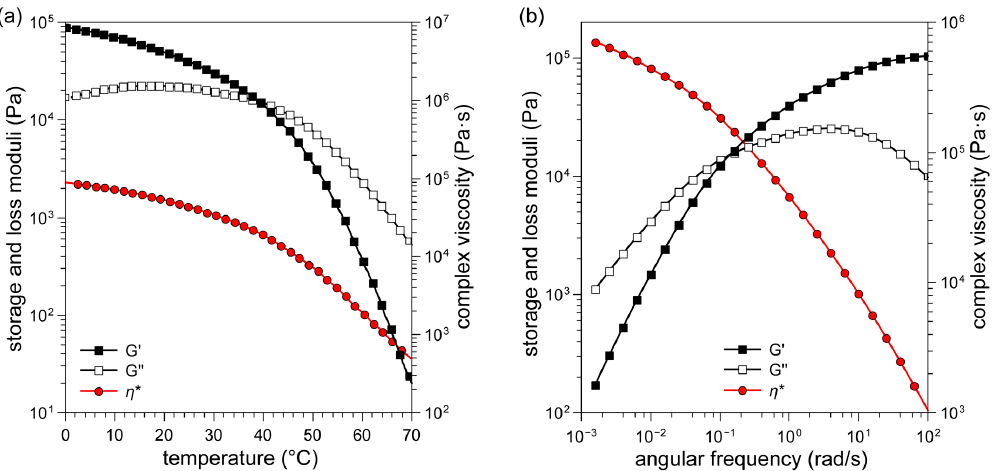
Figure 5. Logarithmic plots of storage modulus (G ′ , black squares), loss modulus (G ′′ , white squares), and complex viscosity ( η *, red circles) of PY-PSBTh dry gel versus ( a ) temperature (1 °C/min on heating, 1% strain, and 1 rad/s); and ( b ) angular frequency (25 °C, 1% strain).